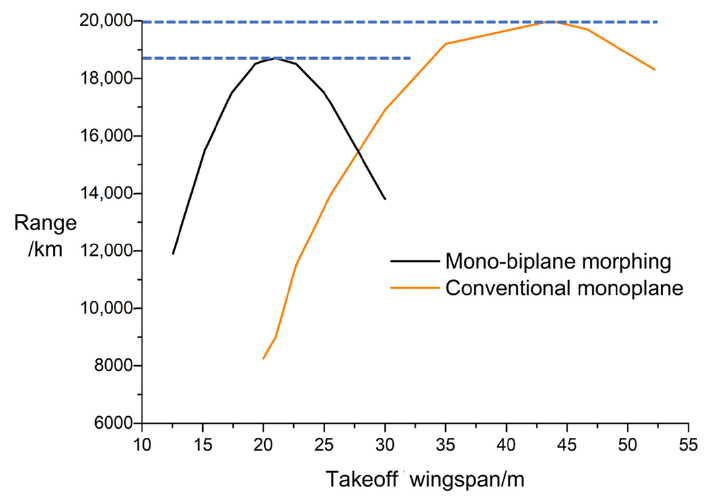
Figure 12. The range of the two aircraft at different wingspans.